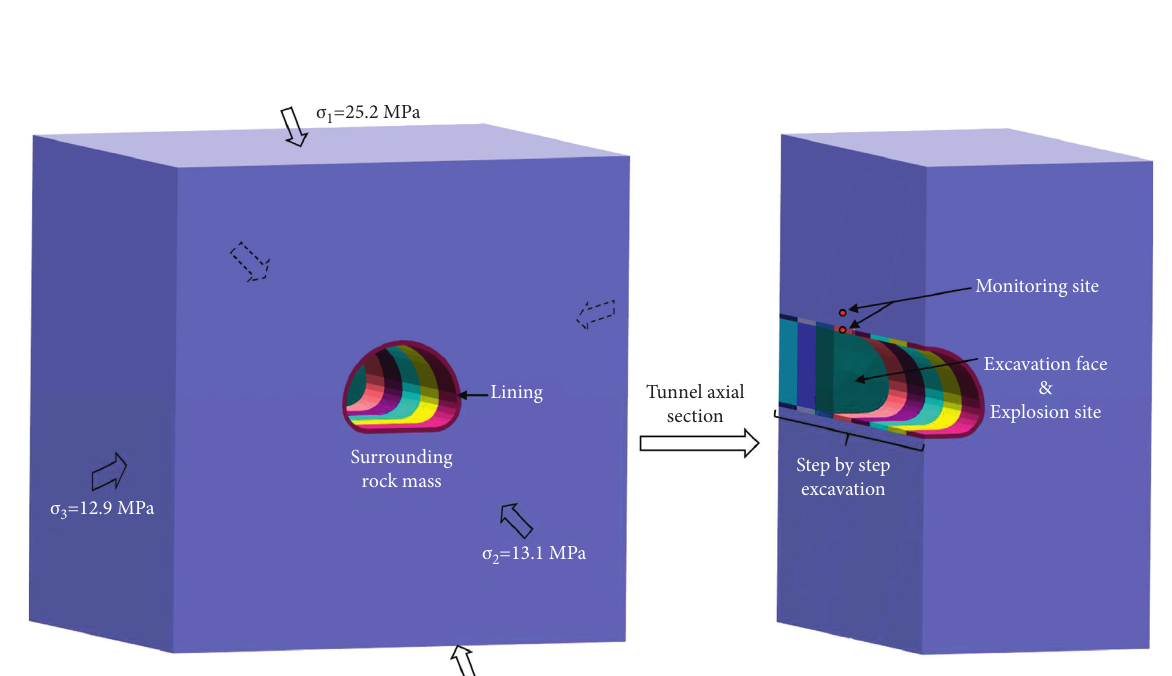
Figure 9: The excavation and blasting model of the Micangshan